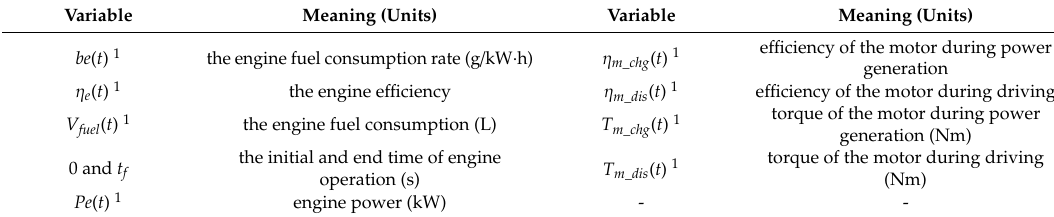
Table 3. Engine and motor model